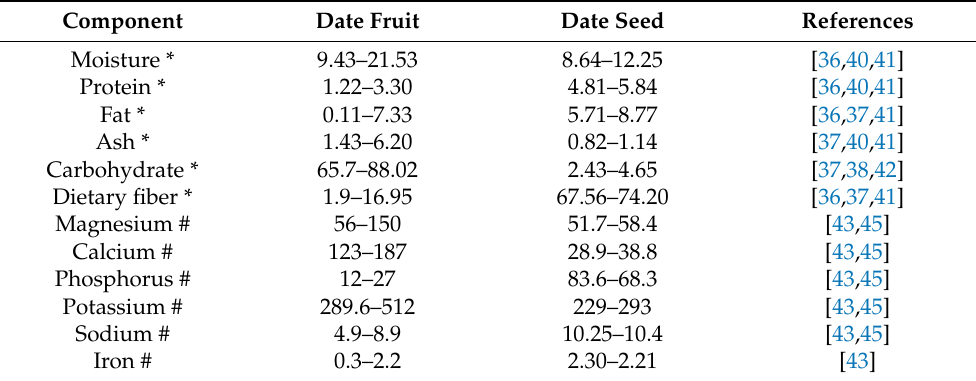
Table 2. Nutrient compositions of date fruit and seed (* g/100 g; # mg/100